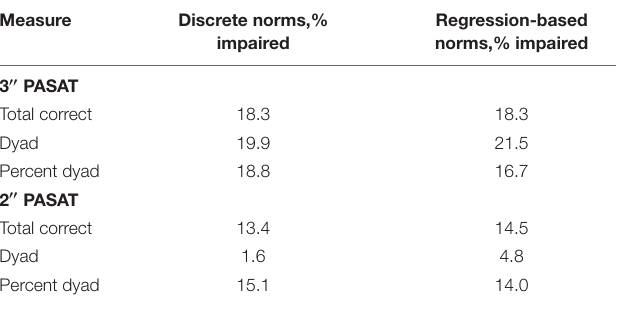
Measure Discrete norms,%